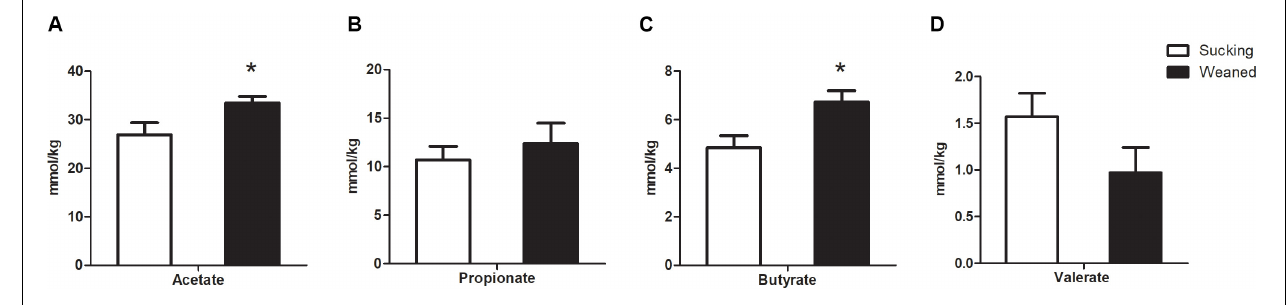
FIGURE 11 | Short-chain fatty acids (SCFAs) concentrations in the feces of sucking piglets and weaned piglets. (A) Acetate. (B) Propionate. (C) Butyrate. (D) Valerate. All values are expressed as the means ± SEMs ( n = 5–6). * P <